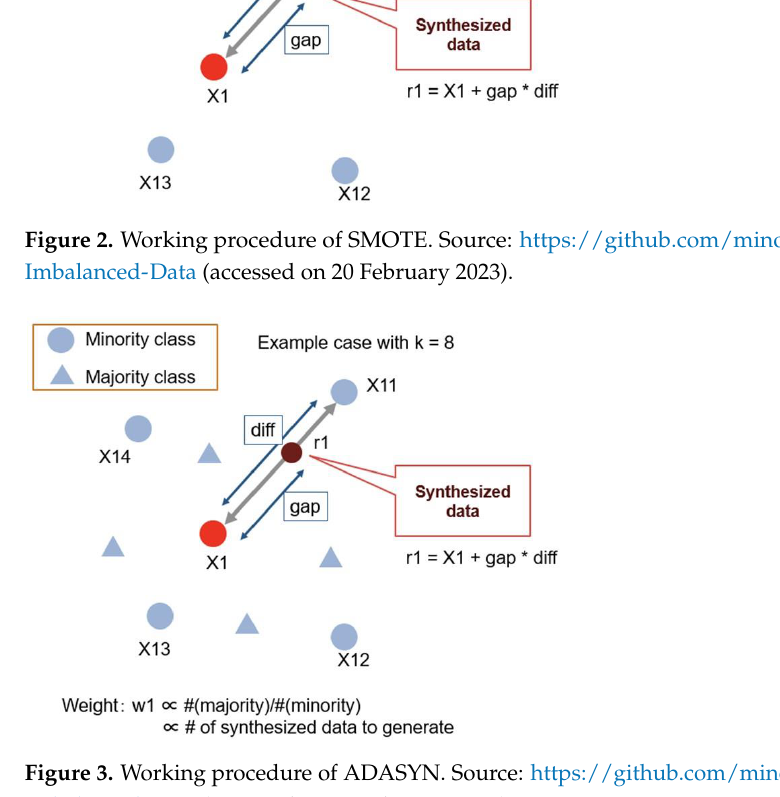
Figure 2. Working procedure of SMOTE.